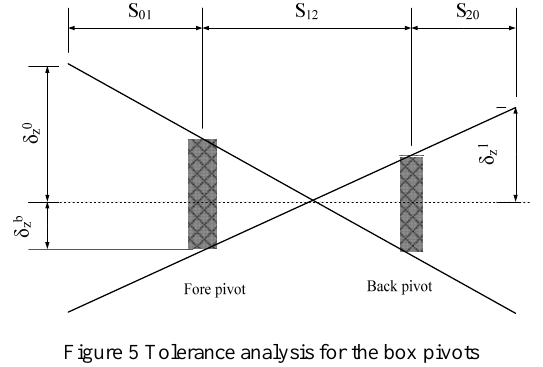
Figure 5 Tolerance analysis for the box